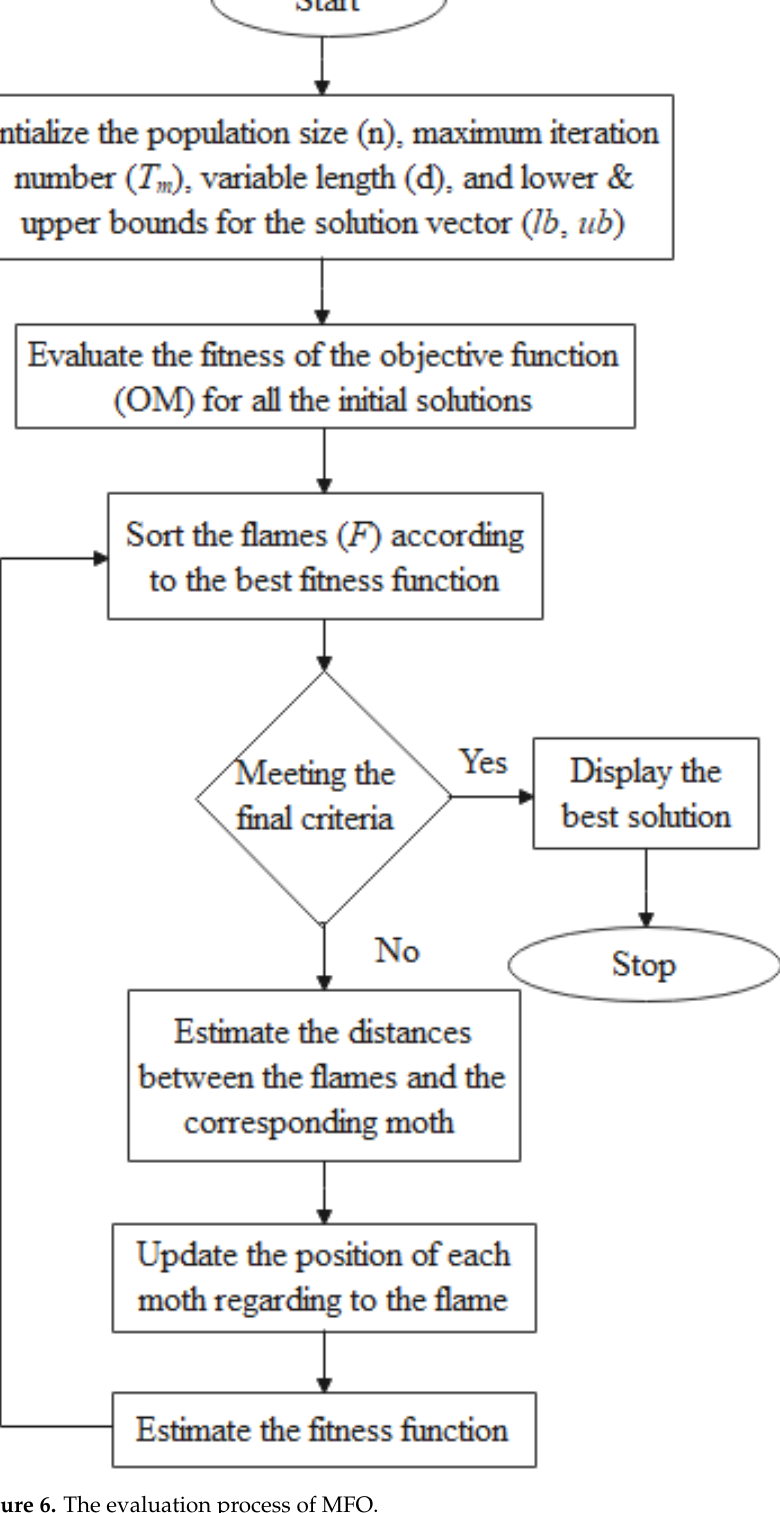
Figure 6. The evaluation process of MFO.